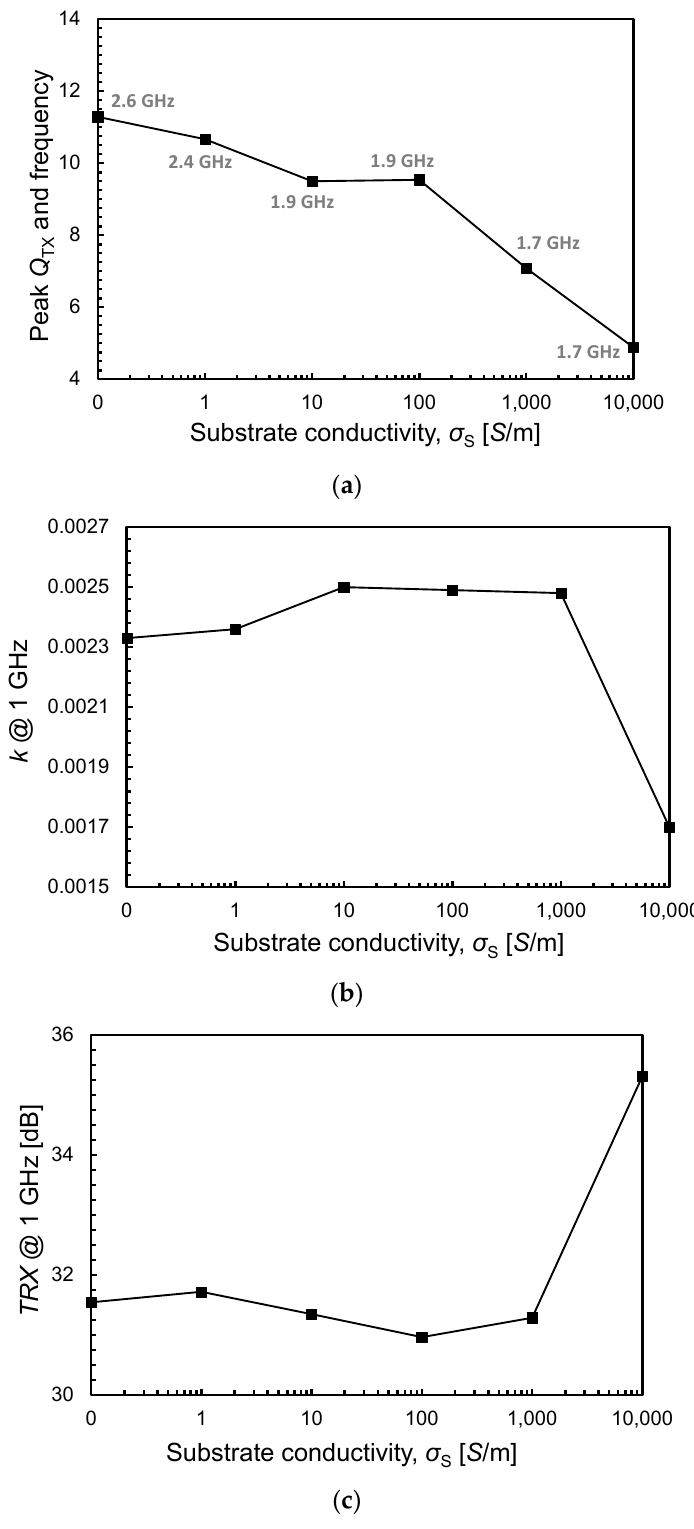
Figure 6. Micro-antenna performance as a function of substrate conductivity, σ S, obtained by means of 3D EM simulations of typical TX/RX antenna configuration at a 600-µm distance: ( a ) peak of Q TX and corresponding frequency; ( b ) magnetic coupling coefficient, k , between TX and RX antennas at 1 GHz; ( c ) TX-to-RX coupling loss at 1 GHz (open-circuit and resonance conditions).